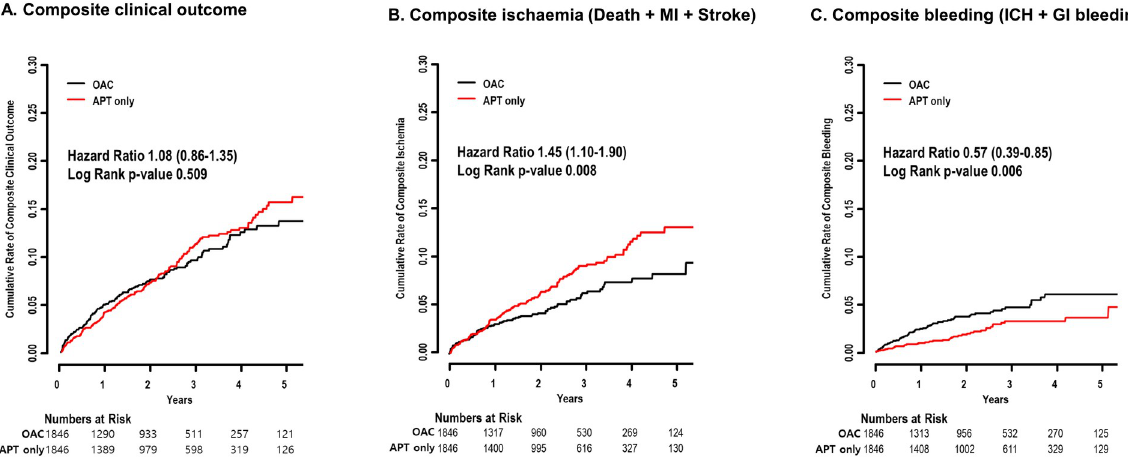
Fig 1. Ischaemic/bleeding risk in patients with AF according to OAC prescription at 1 year after PCI. Cumulative risk of composite clinical outcome (Fig 1A), composite ischaemia (Fig 1B), and composite bleeding (Fig 1C) was compared between patients with OAC and APT only. AF = atrial fibrillation, APT = antiplatelets, GI = gastrointestinal, ICH = intracranial hemorrhage, MI = myocardial infarction, OAC = oral anticoagulants, PCI = percutaneous coronary intervention.